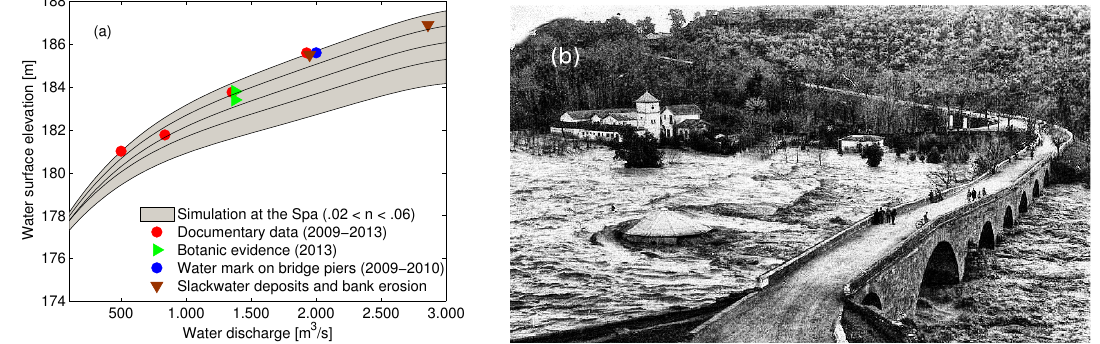
Figure 3. ( a ) Rating curve at the bridge/Spa based on in situ photographs during 2009–2013 floods, botanical high-water marks (HWMs), mud-lines on bridge piers and overbank flood-deposited